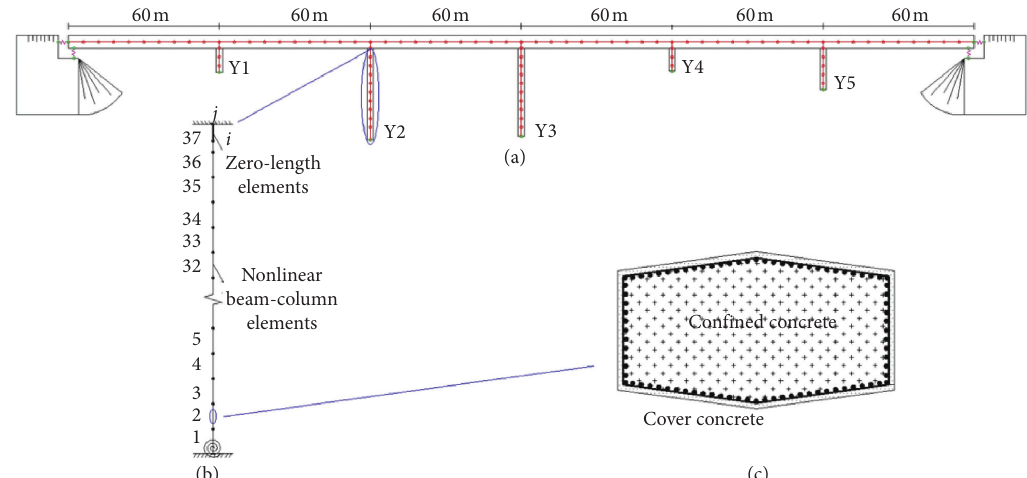
concreteConfined concrete